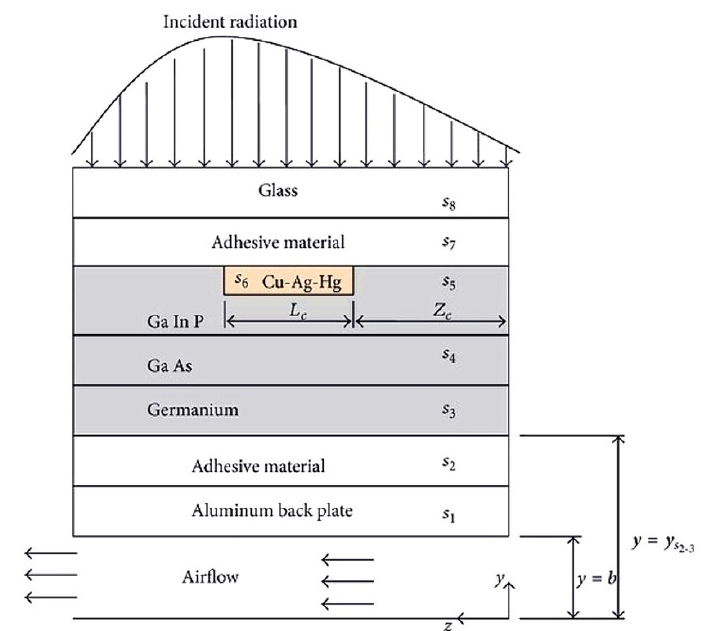
Figure 16. Schematic of the triple-junction CPV system integrated with forced air cooling device [88].